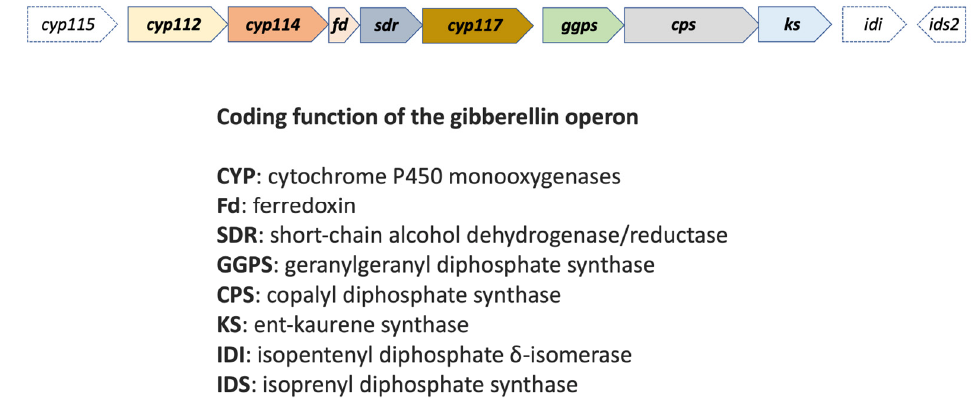
Figure 3. Coding functions of the gibberellin operon. Figure adapted from